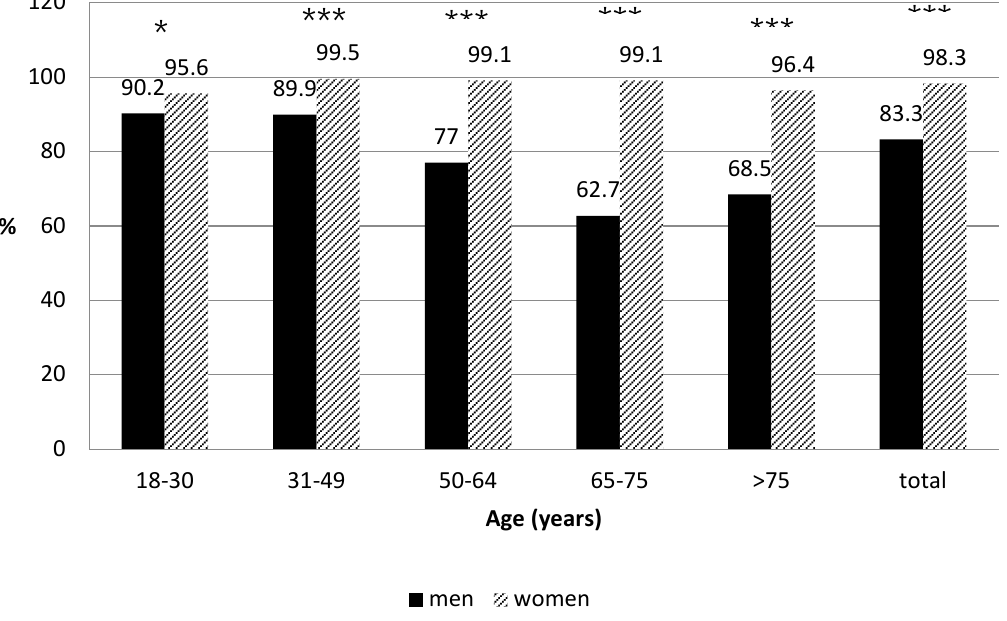
Figure 1. The percentage of survey respondents who stated that they know how to cook. The sample sizes by age groups were as follows: 18–30 years: 131 men and 189 women; 31–49 years: 332 men and 469 women; 50–64 years: 185 men and 275 women; 65–75 years: 84 men and 134 women; >75 years: 71 men and 156 women. * p < 0.05; *** p < 0.0005, women vs. men.